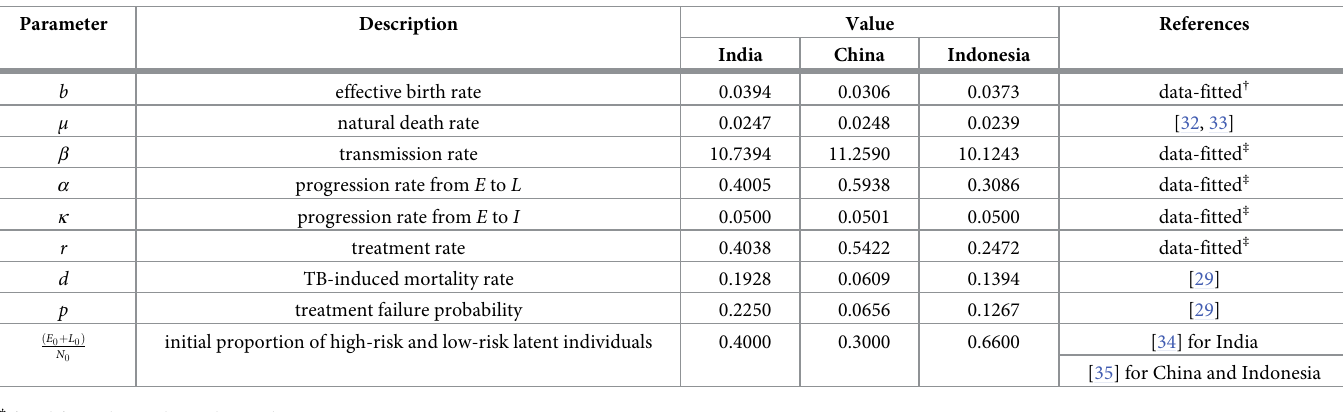
Table 1. Epidemic parameters of the TB transmission model.